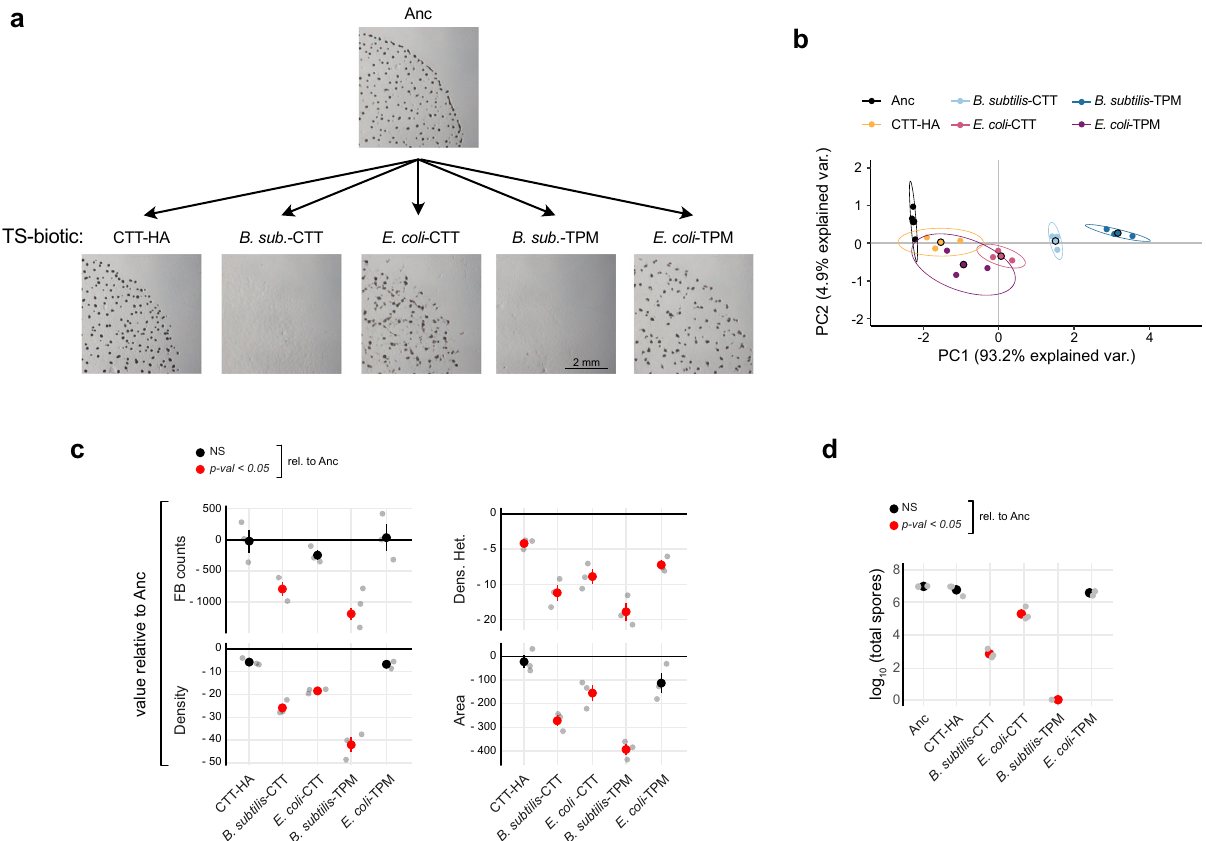
Fig. 4 Prey presence and identity shape developmental LPE. a Developmental phenotypes of representative TS-biotic evolved populations from each selective environment and Anc (CTT-HA = P1; B. subtilis- CTT = P99; E. coli -CTT = P93; B. subtilis -TPM = P133; E. coli -TPM = P127). b PCA of overall morphological divergence across all fi ve TS-B evolutionary treatments (MyxoEE-3 cycle 18) and the Anc subclones. Large circles represent average morphospace localization (centroids) obtained from three independent biological replicates (small circles, n = 3), while ellipses represent a 95% con fi dence region. Percentage values on the x and y axis report the variation explained by the two principal components, PC1 and PC2, respectively (Supp. Fig. 5B). c Mean values ± SEM of individual developmental traits relative to the ancestral (Anc) levels (black-horizontal line in each graph) ( n = 3). d Mean values ± SEM of log 10 -transformed spore counts obtained after fi ve days of starvation ( n = 3). In both c and d , red and black circles indicate signi fi cant ( p < 0.05) and non-signi fi cant (NS) differences from Anc levels, respectively. (Signi fi cance was calculated for both c and d with one-way ANOVA followed by two-tailed Tukey tests. p values of all comparisons of evolved treatments with Anc, as well as all pairwise comparisons between evolved treatments, are reported in Data Fig.